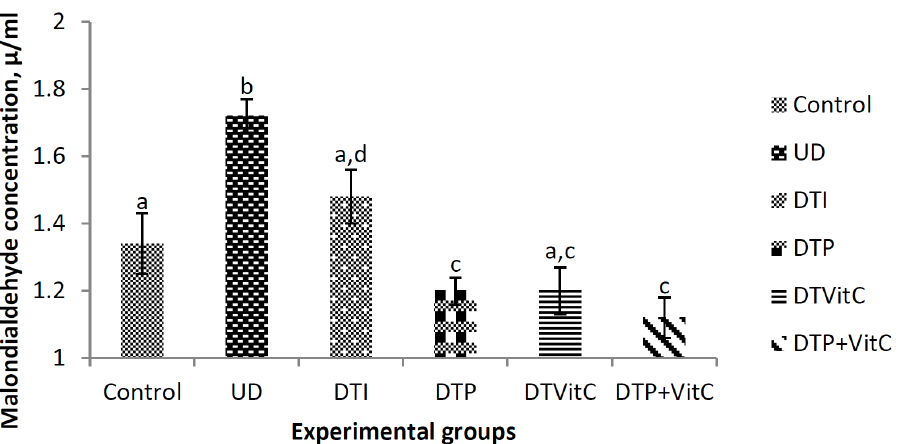
Figure 1. Effects of treatment with insulin, probiotic and vitamin C on serum MDA concentration in alloxan ‐ induced diabetic rats. Abbreviations: UD, untreated diabetic; DTI, diabetic + treated with insulin; DTP, diabetic + treated with probiotic; DTVit ‐ C, diabetic + treated with vitamin C; DTP + Vit ‐ C, diabetic + treated with probiotic and vitamin C. The values are expressed as mean ± S.E. ( n = 5). Values with superscript letters are significantly ( p < 0.01) different.